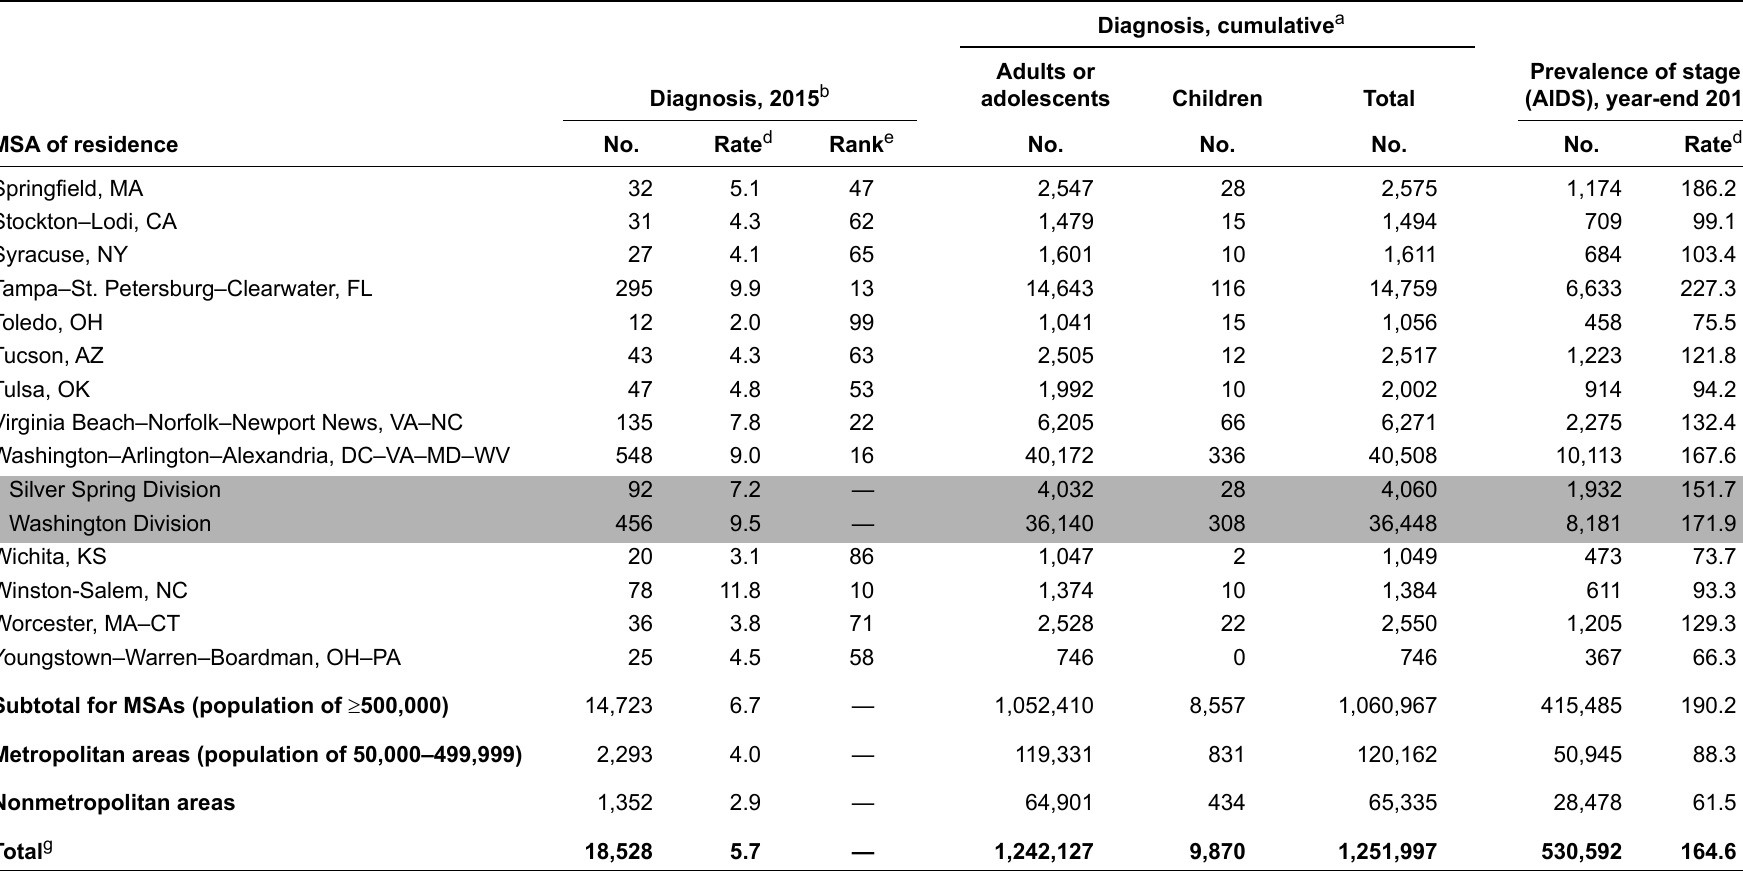
Table 27. Stage 3 (AIDS), 2015 and cumulative, and persons living with diagnosed HIV infection ever classified as stage 3 (AIDS) (prevalence), year-end 2014, by metropolitan statistical area of residence—United States and Puerto Rico